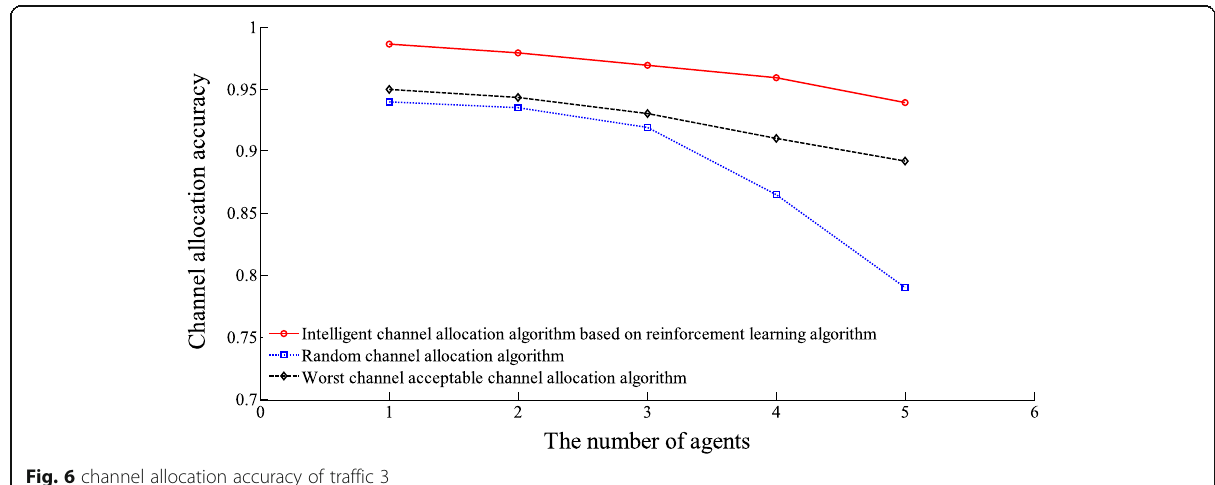
Fig. 6 channel allocation accuracy of traffic 3